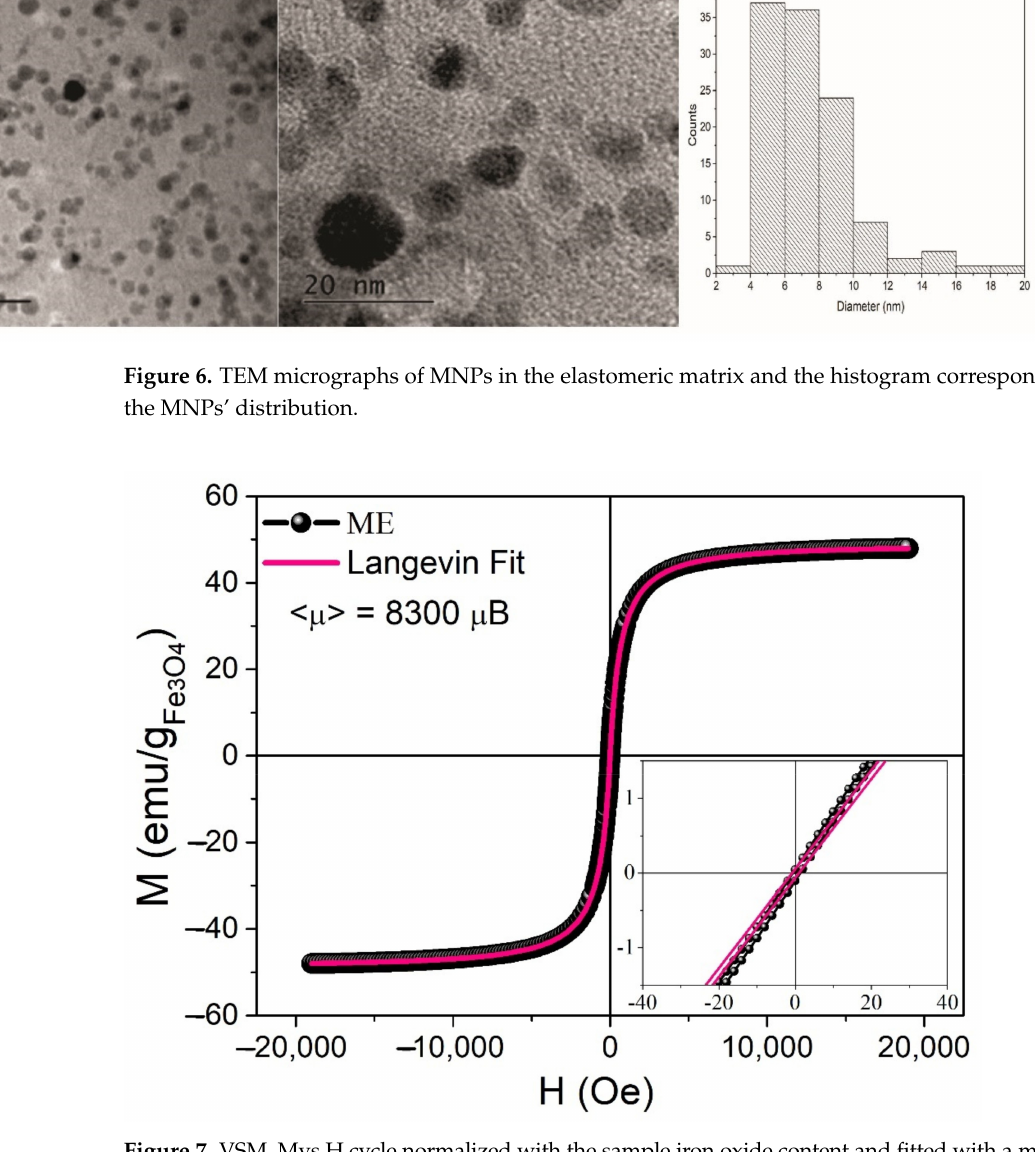
Figure 7. VSM, Mvs.H cycle normalized with the sample iron oxide content and fitted with a magnetic